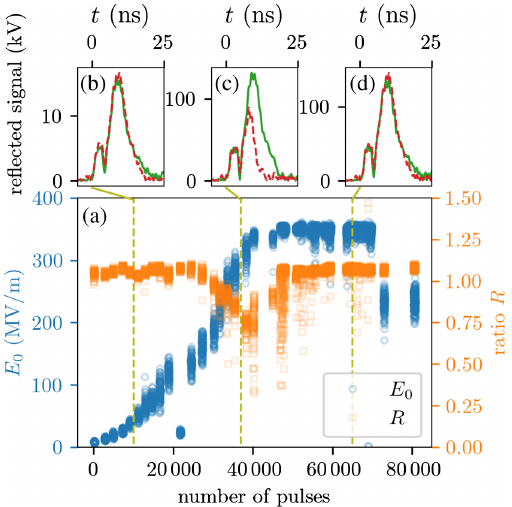
FIG. 2. rf conditioning history of the XRF gun (a) where the photocathode peak field E 0 was gradually increased (blue circle) and the ratio of the peak value of the measured to simulated reflected rf signals, R , recorded (orange square). The upper plots (b) – (d) compared the measured (dash red trace) and simulated (green solid trace) rectified rf-reflection signals at different stages of the conditioning history indicated with the dash vertical lines.